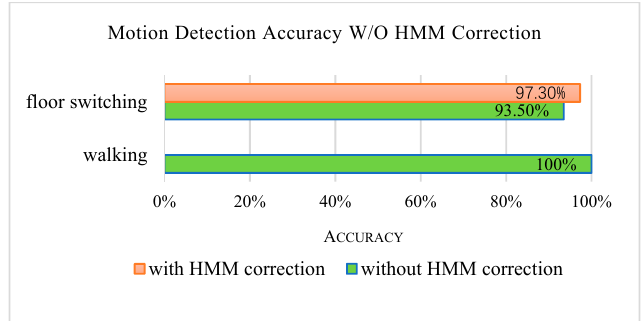
Figure 6. Motion detection accuracy W/O the HMM correction.